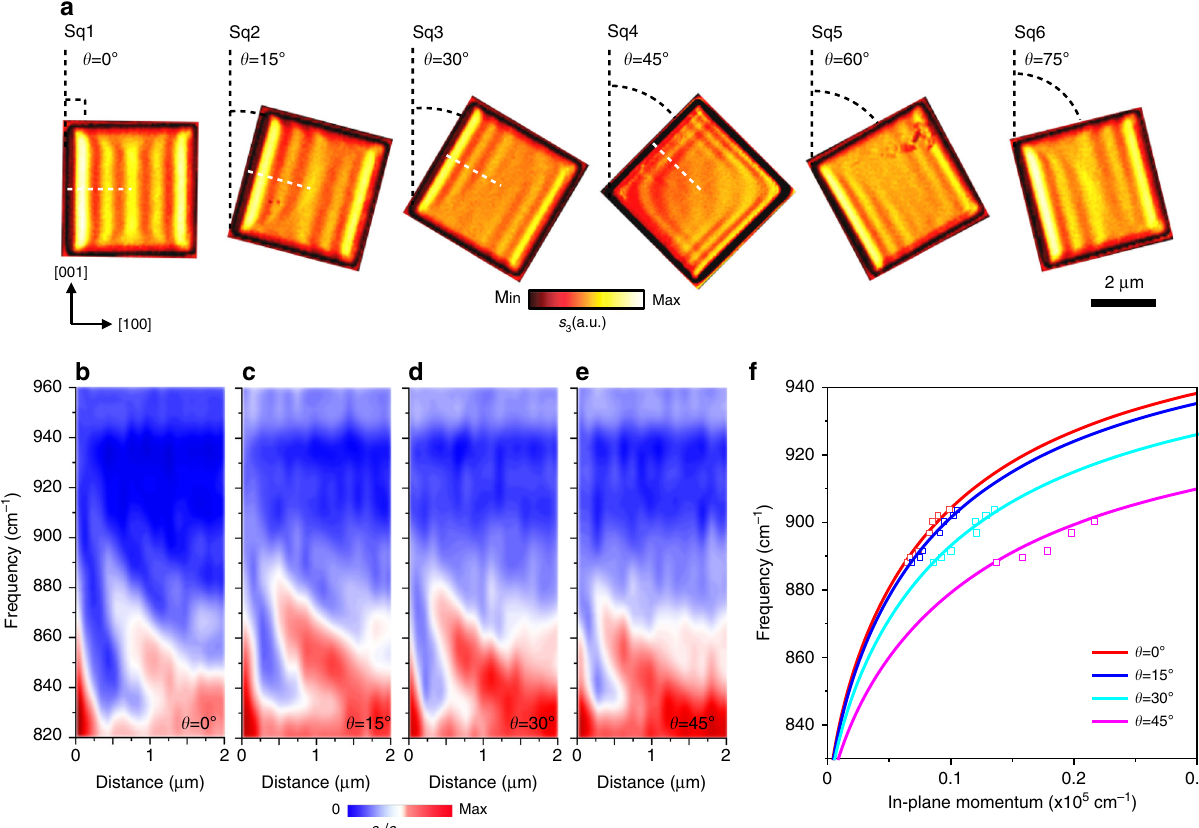
Fig. 2 Edge-tailored PhPs in square α -MoO 3 nanocavities. a Real-space imaging of edge-tailored PhPs in rotated square nanocavities (side length: 4 μ m; thickness: d = 175 nm) which was fabricated in the same piece of α -MoO 3 sample. b – e Nano-FTIR spectral line scans perpendicular to the rotated edges (white dotted lines in Sq1 – Sq4), showing the near- fi eld amplitude s 2 ( ω ) (normalized to the near- fi eld amplitude on the SiO 2 substrate, s 2,SiO2 ( ω )) as a function of distance between tip and edge. Color dashed lines are guides for the eye of signal maxima. f Dispersion relation of hyperbolic PhPs in square α - MoO 3 nanocavities. The red, blue, cyan and pink line corresponds to the theoretical dispersions at different rotation angles θ = 0°, 15°, 30°, and 45° respectively. The squares correspond to the experimentally measured